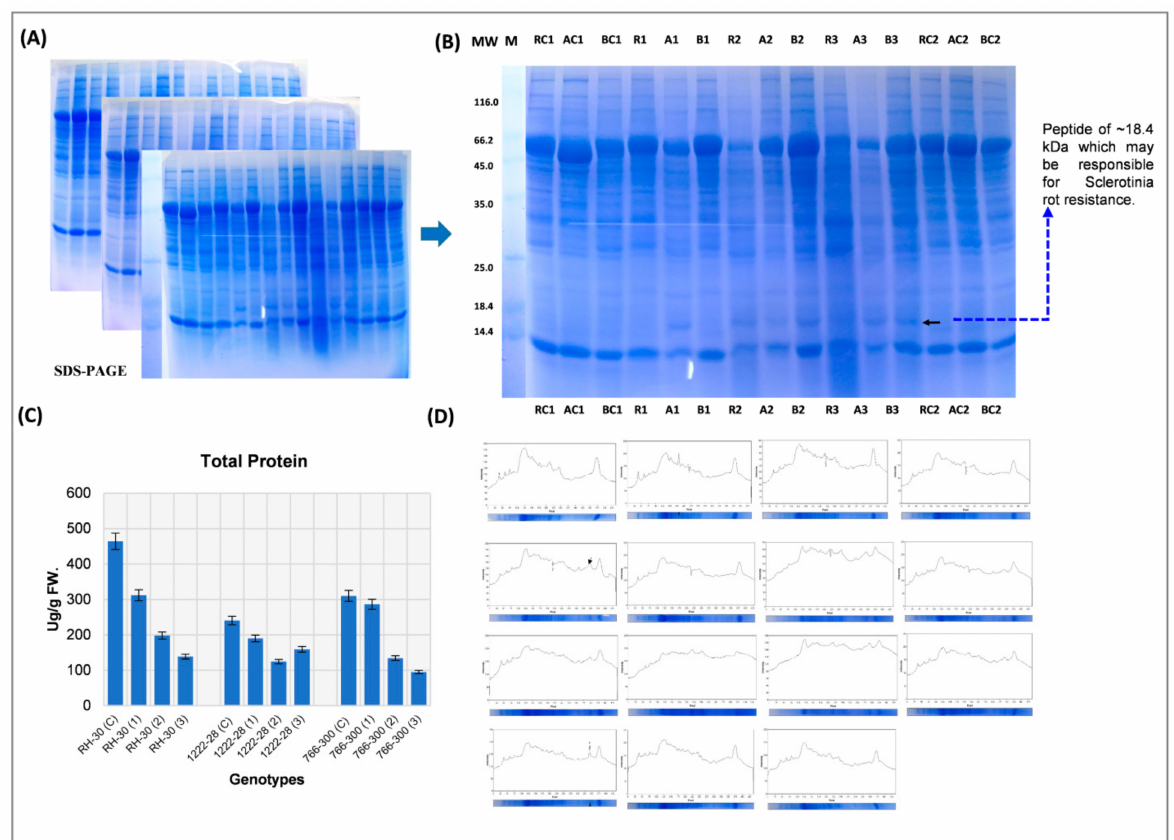
Figure 4. Protein expression profile of various genotypes by using SDS-PAGE: R = RH-30; A = RH 1222-28; B = EC 766,300; C1 and C2 = Control before infection and control at the time of infection; R1, A1 and B1 = First Infection; R2, A2 and B2 = Second Infection; R3, A3 and B3 = Third Infection. Arrow indicating the presence of a particular peptide of ~18 kDa which may be responsible for Sclerotinia rot resistance; ( A , B ) total protein content; ( C ) densitometry analysis of expression profile ( D